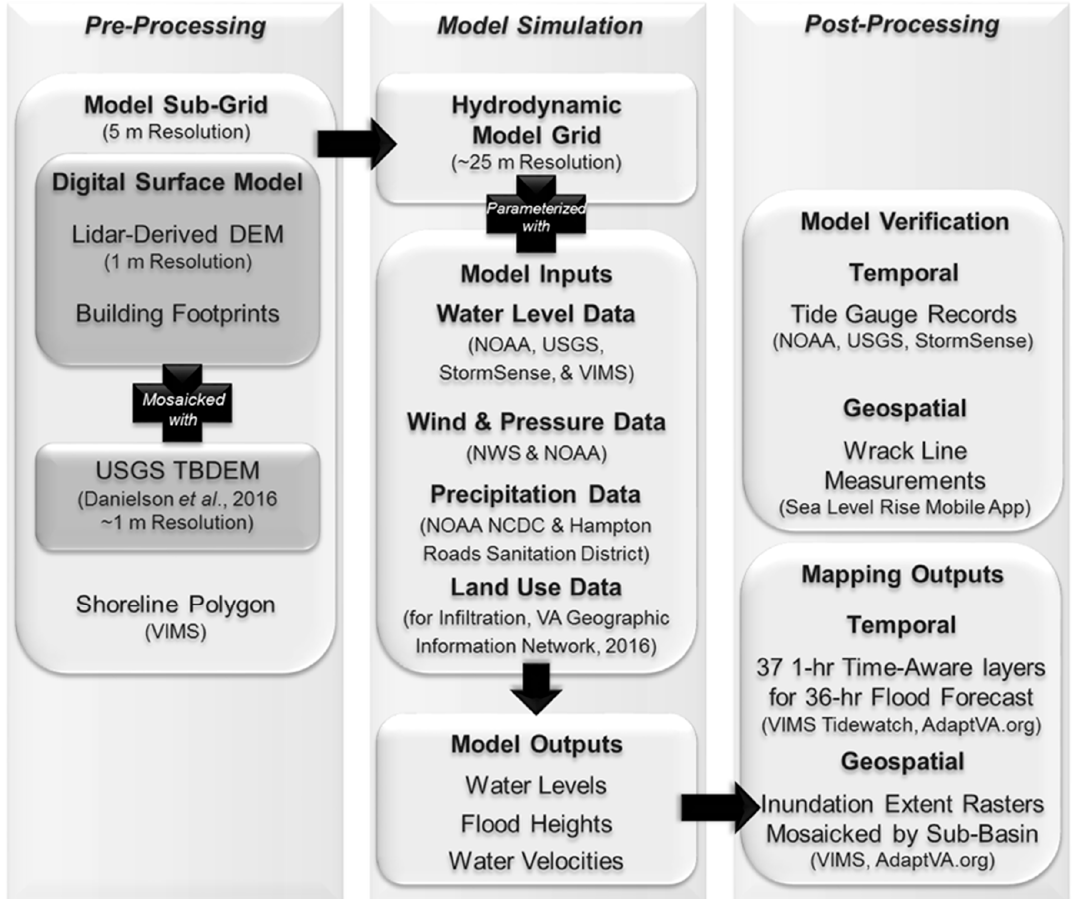
Figure 5. Automation flowchart for SCHISM model initiation and simulation for every 36-h forecast. The Tidewatch model updates twice daily, outputting mapping outputs at AdaptVA.org at noon and midnight local time (05:00 and 17:00 UTC).